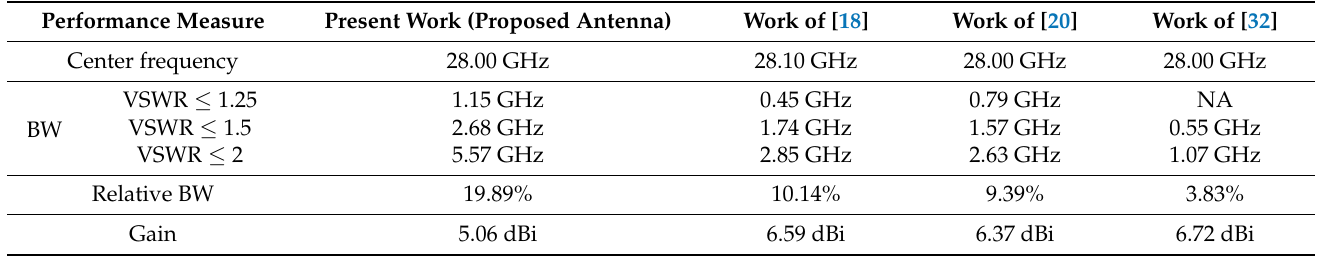
Table 3. Comparisons among the bandwidth achieved in the present work to those achieved in other published works. Performance Measure Present Work (Proposed Antenna) Work of